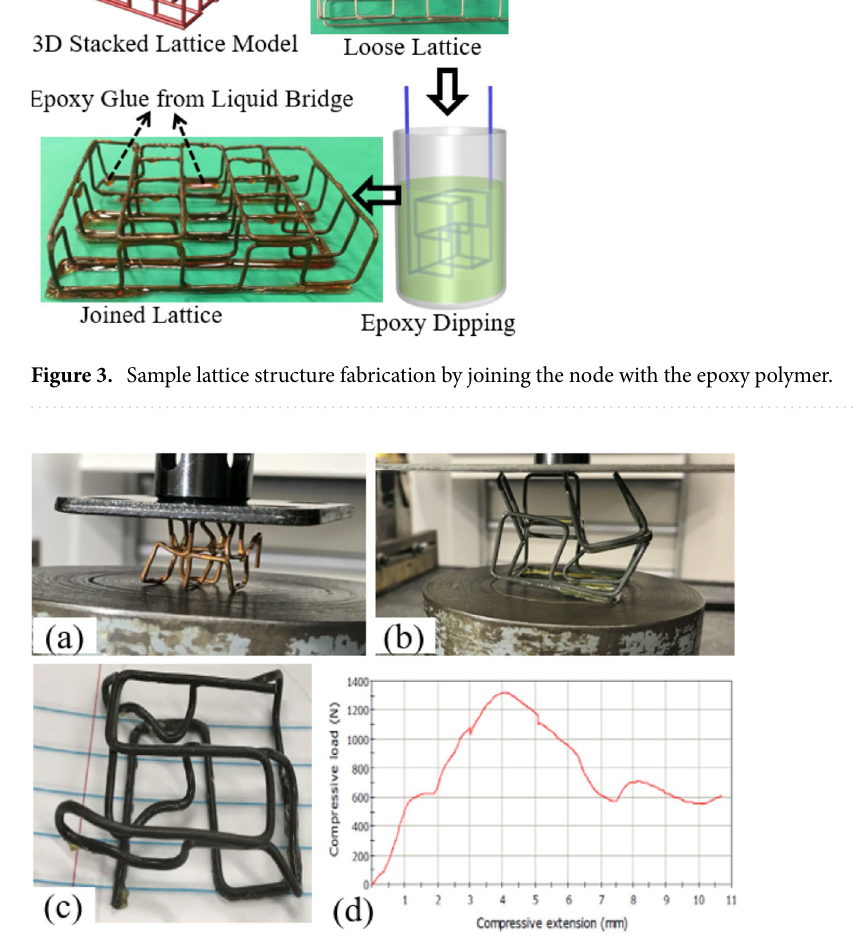
Figure 4. Compressive test of lattice structure with the continuous rod. The nodes are joined with 2000 Epoxy Resin and 2120 Epoxy Hardener ( a ) Copper wire Ф = 1.02 mm, cell size 5 mm; 2 × 2 × 2 structure ( b ) and ( c